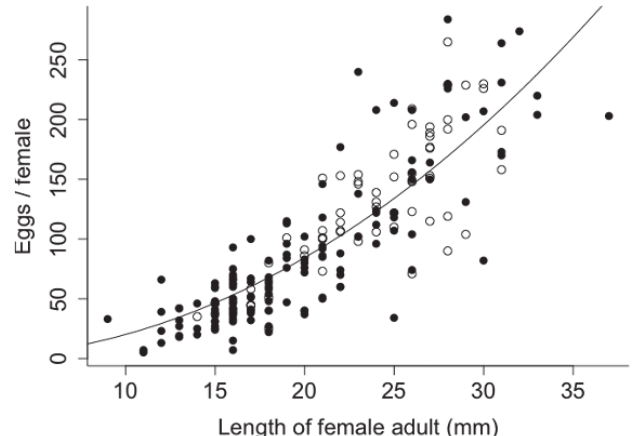
Figure 2. Relationship between body size and fecundity. Number of eggs (y) increases with female Sirex noctilio body size at the same rate for the main data set (closed circles) and Central NY data set (open circles). Line is fitted power function y = 0.17x 2.072 for the combined data